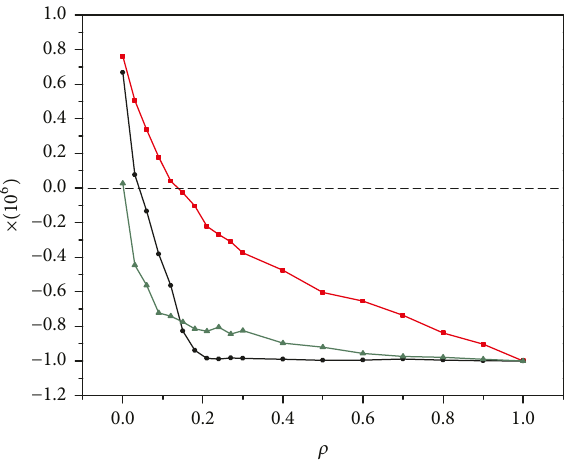
Figure 8: Dependence of mean field (at time 10 6 ) on the ratio 𝜌 of fanatics (having fixed position on the lattice) for the bottom-up SOTC model (red line), top-down SOTC model (black line), and ordinary DMM with tuned control parameter 𝐾 𝑐 = 1.5 (green line). Ensemble average is done over 10